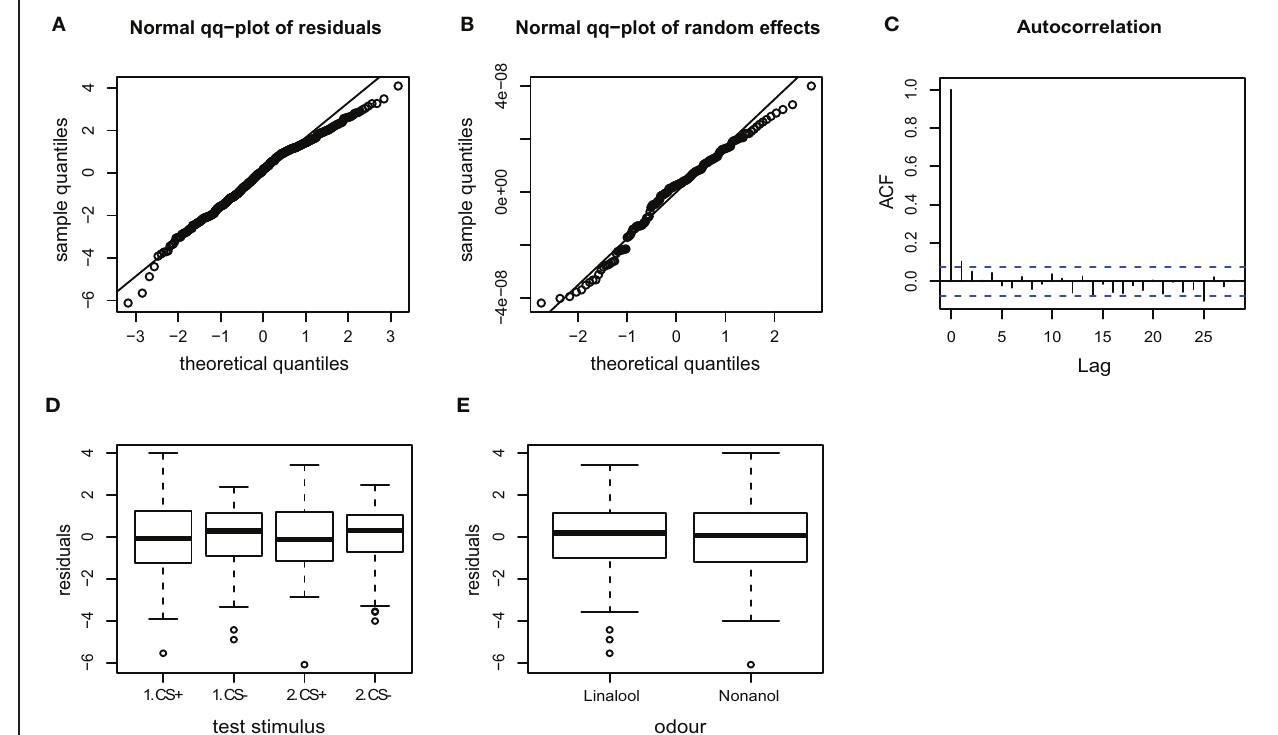
FIGURE A3 | Goodness of fit and diagnostic plots of residuals for linear mixed model used to predict velocity for APIS. (A) Quantile probability plot showing the quantiles of the residuals of the observed velocity vs. the theoretical quantiles of a normal distribution. The velocity data mostly follows a normal distribution, but with a slightly heavy tail in the upper quantiles. This indicates that the upper values vary slightly less than when assuming an ideal normal distribution. (B) Quantile probability plot of the random effect (bee), indicating that the residuals of the velocity among the 174 tested bees follows a normal distribution. (C) Autocorrelation plot of the deviance residuals (first bar indicating the residual correlated with itself). The following bars each indicate correlation to the previous residual. Less than 5% of the